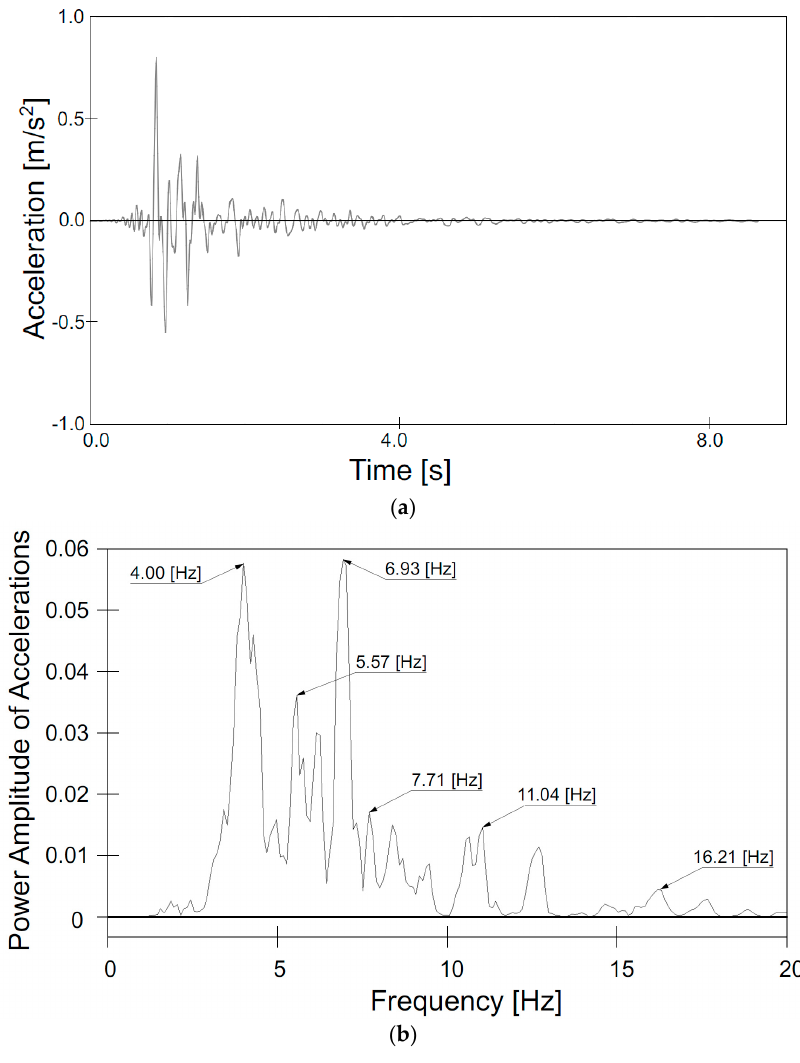
Figure 3. Rockburst on 12 December 2015: ( a ) Record of ground motion of north ‐ south (NS) component, ( b ) frequency of vibration.